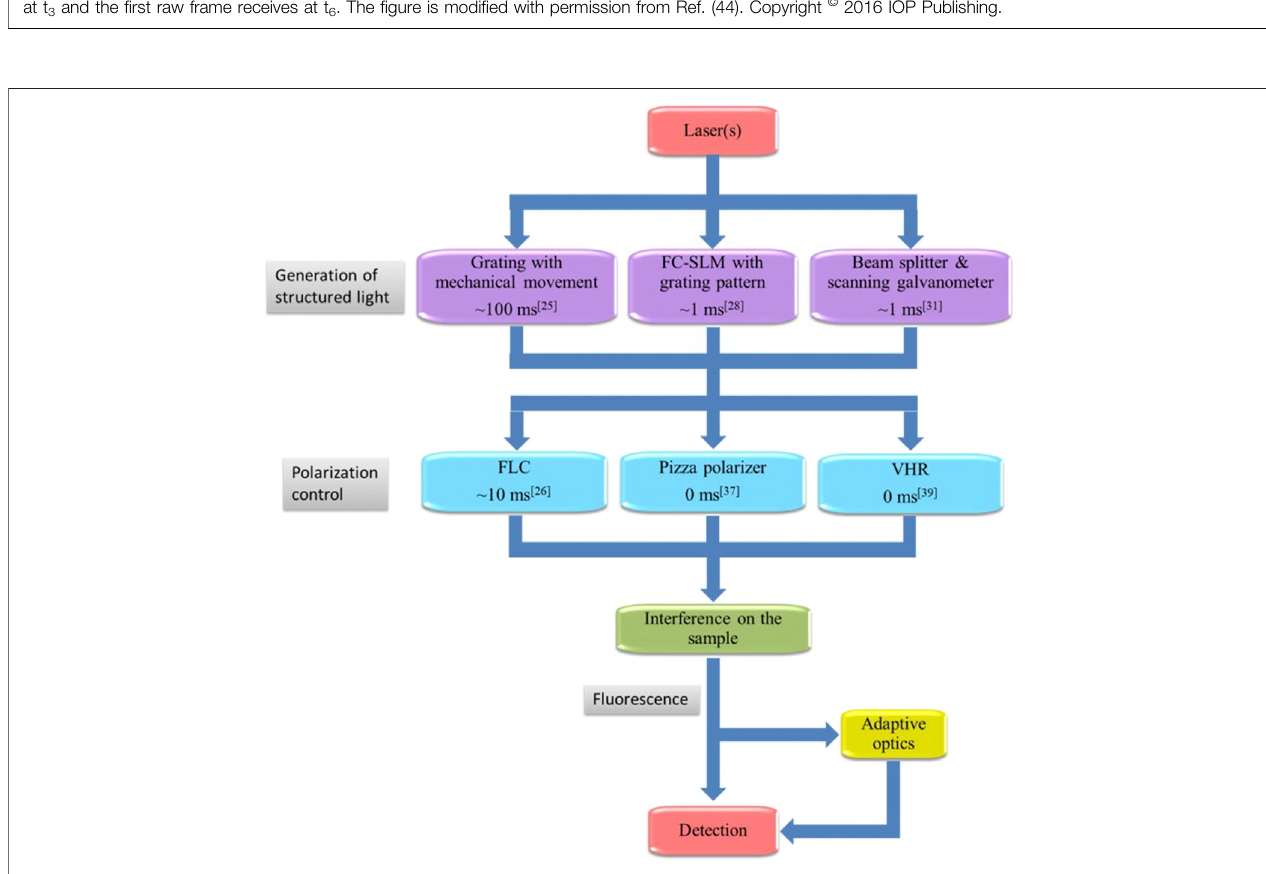
FIGURE 6 | The fl owchart for SIM. The majority of SIM systems illuminate samples with one or more lasers. The laser beam is then passed through a pattern- generating system, polarization control system, and interference on the sample. The fl uorescence can be optimized by adaptive optics before being detected by the